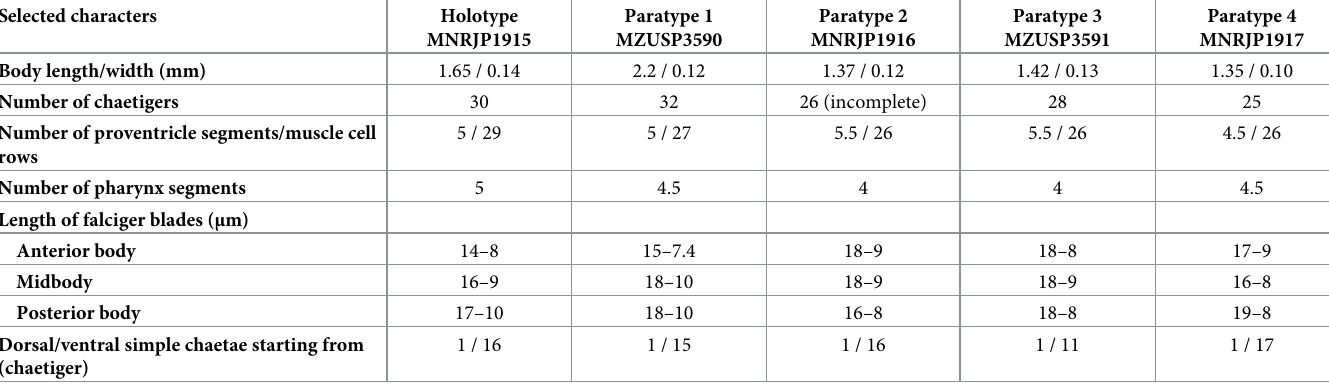
Table 3. Morphological variation of selected characters among specimens in the type series of Salvatoria ypsiloides n. sp. Selected